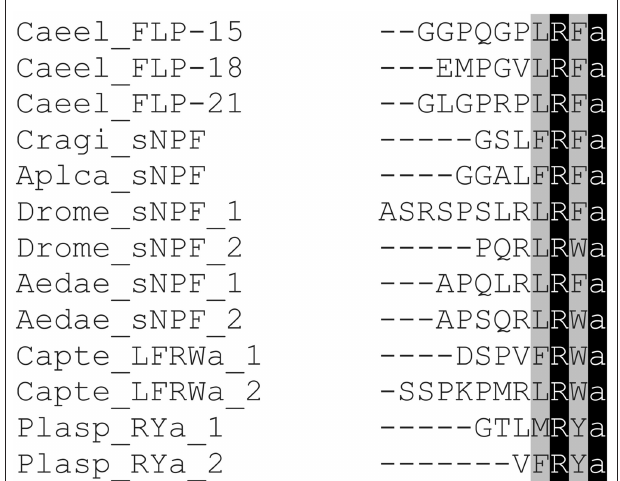
FIGURE 4 | Amino acid sequence alignment of representatives of sNPFs from different invertebrate phyla. Genus and species abbreviations used in the alignment are: Caeel, Caenorhabditis elegans; Cragi, Crassostrea gigas; Aplca, Aplysia californica; Drome, Drosophila melanogaster; Aedae, Aedes aegypti; Capte, Capitella telata; Plasp, Platynereis species. Identical residues are highlighted in black and conserved residues in